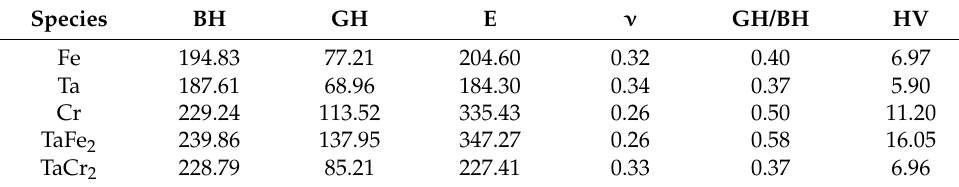
Table 9. Calculated